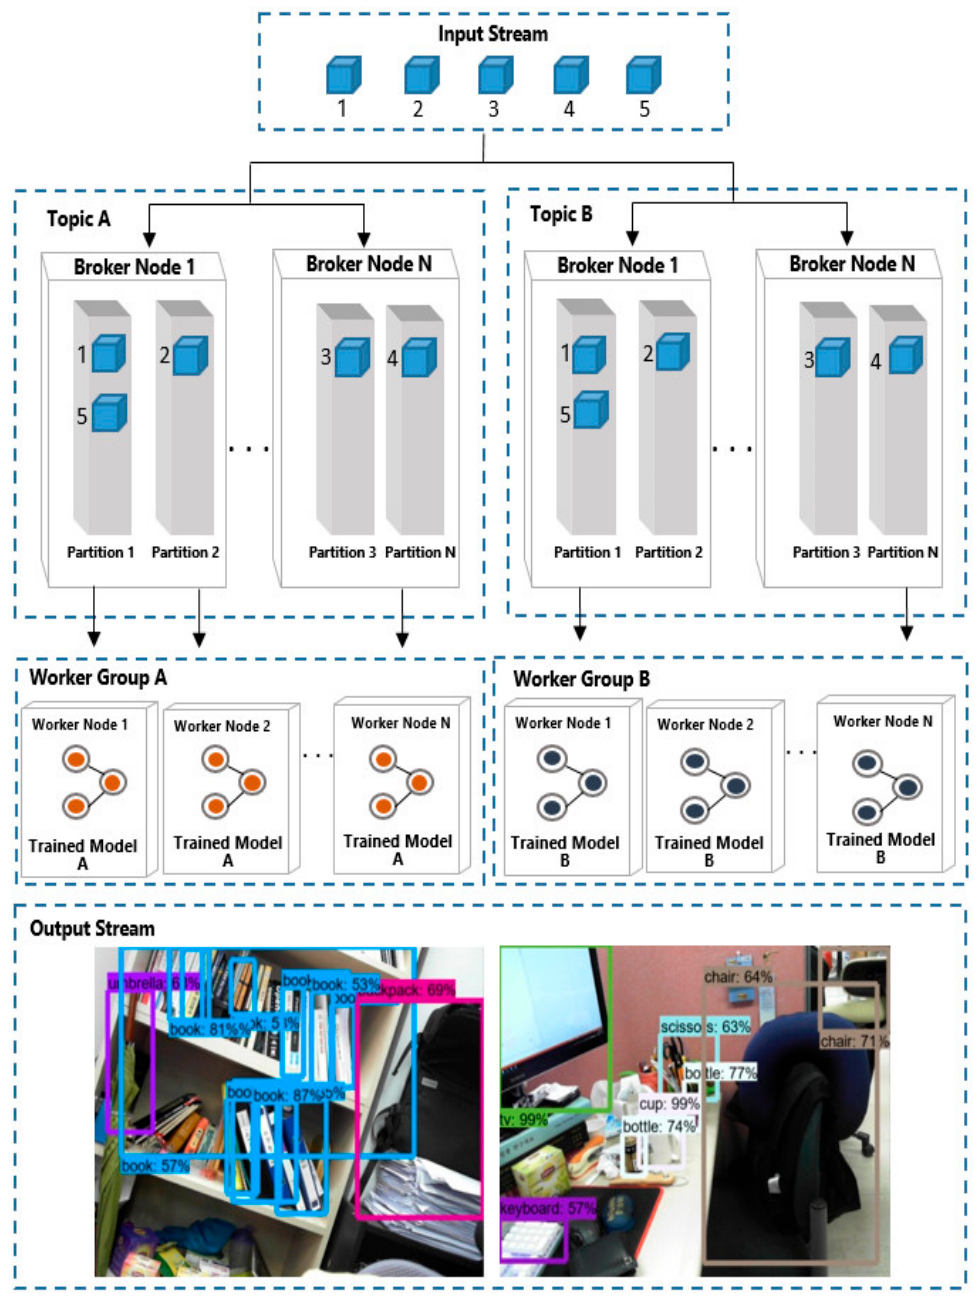
Figure 10. Result of implementation .